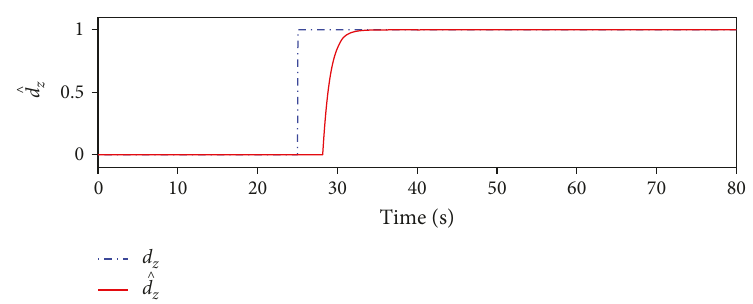
Figure 8: The estimate of the d